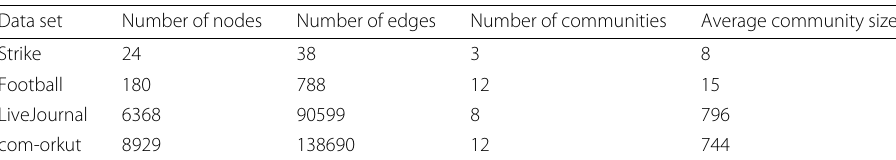
Table 1 Data set information